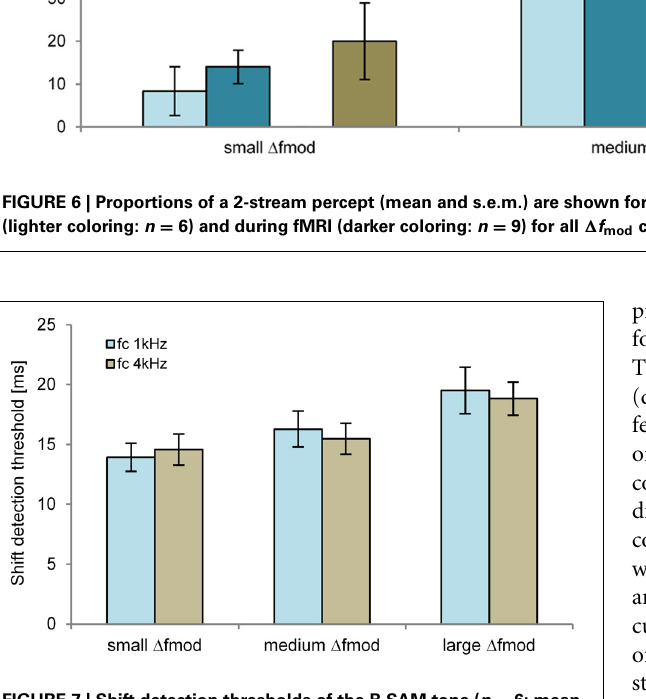
FIGURE 7 | Shift detection thresholds of the B SAM tone ( n = 6; mean and SEM) are shown for the f c of 1kHz (blue) and 4kHz (brown) for all (cid:2) f mod